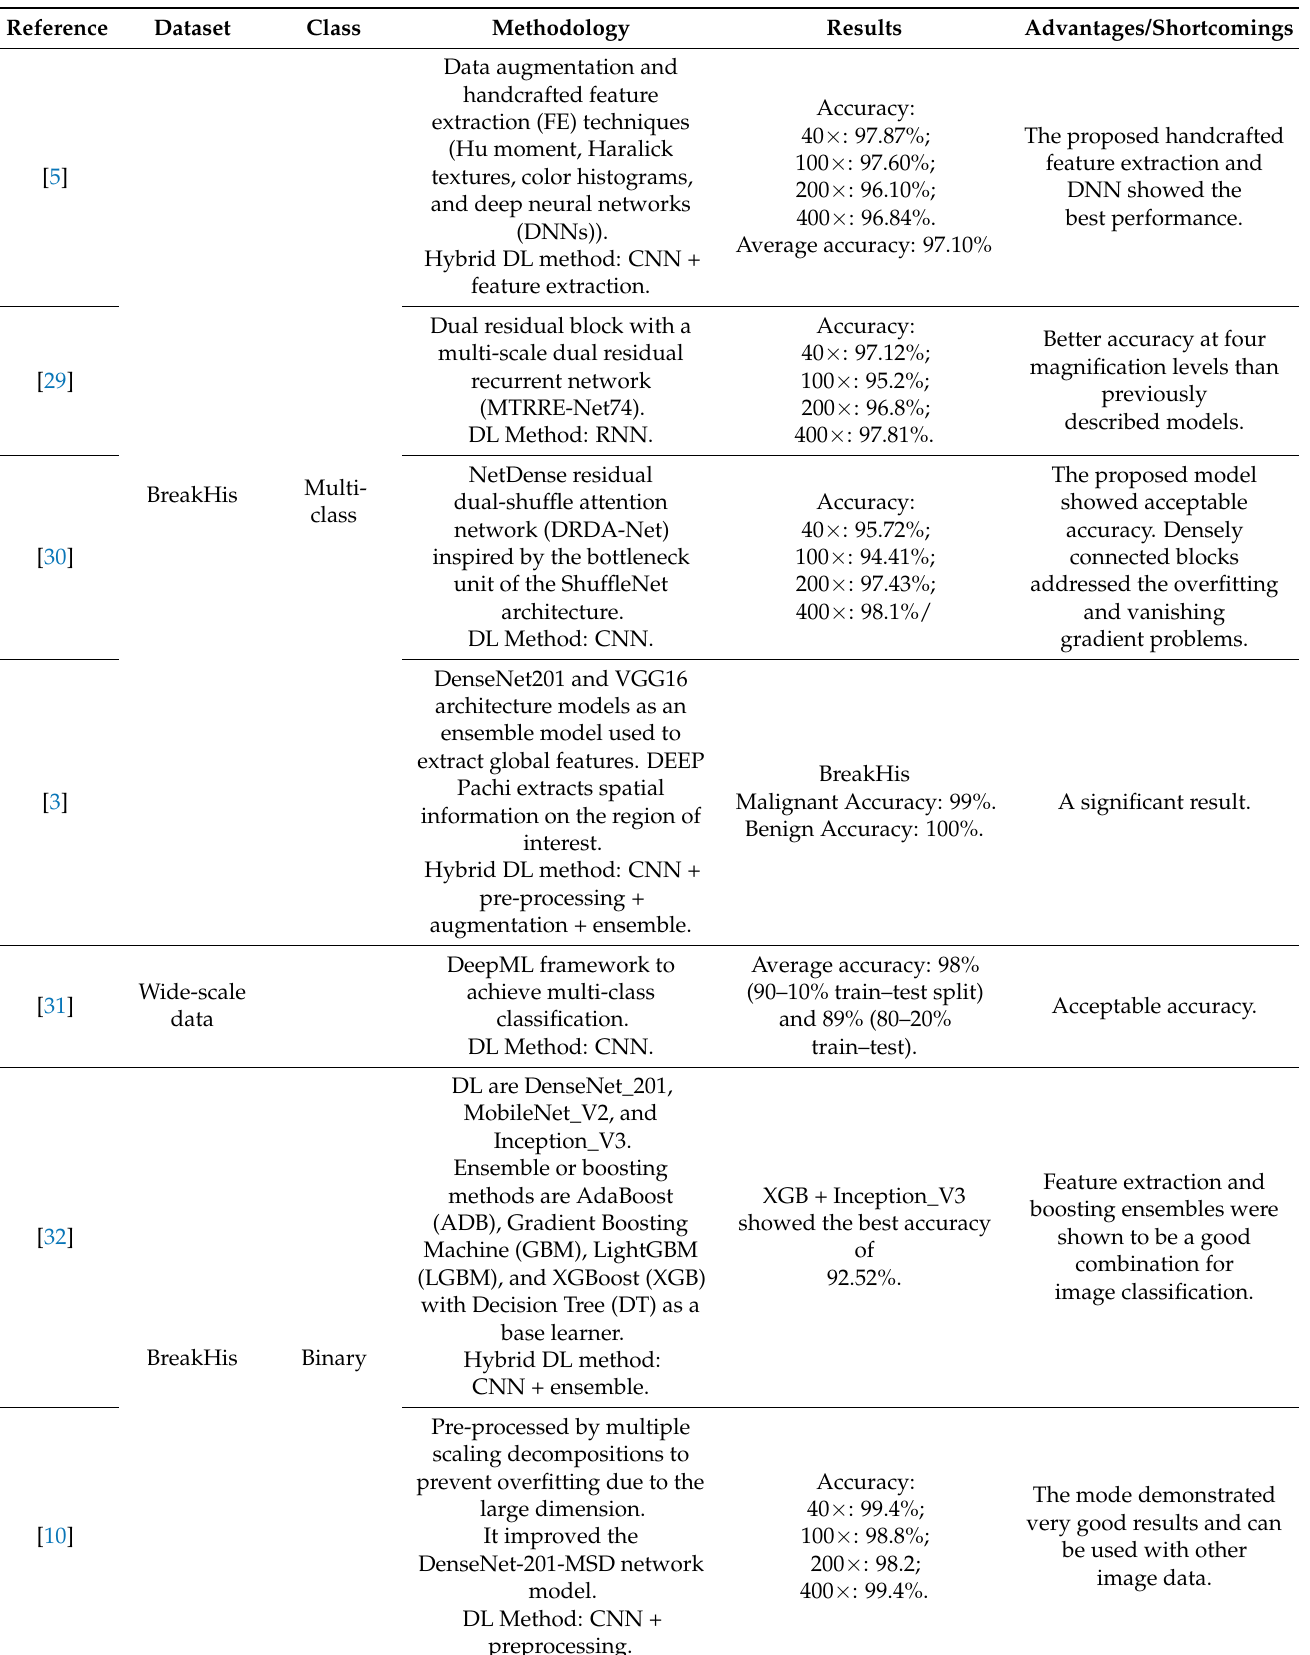
Table 3. Summary of recent deep learning